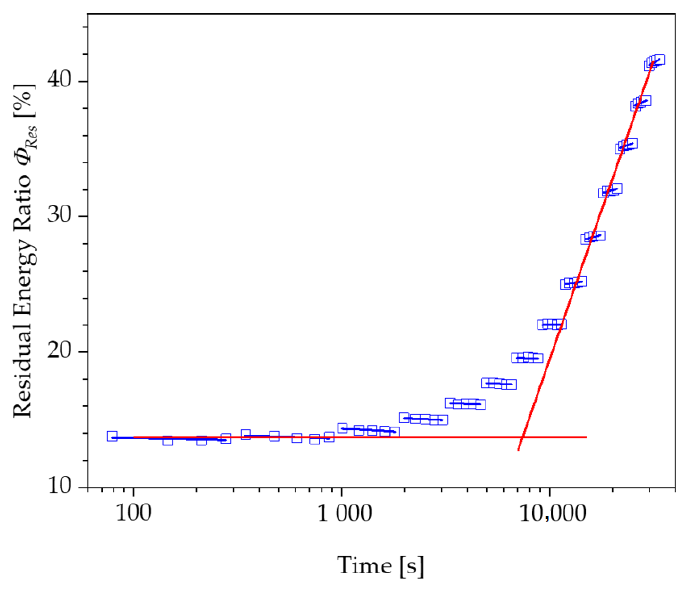
Figure 10. Tangent approach for the determination of a strain limit based on the residual energy ratio curve of the PUR Neukadur ® . The point of intersection of these tangents characterises the transition with a corre- sponding load amplitude, above which a steady increase in the energy loss of a loading and unloading cycle occurs. However, the authors would like to discuss an alternative proposal for the determination of the strain limits compared to the evaluation using tan- gents. Instead of a user-dependent construction of two tangents, the slope of the linear course of the residual energy ratio of a load level is plotted over the displacement of the specimen or the corresponding strain to be assigned to this load (Figures 11 and 12).